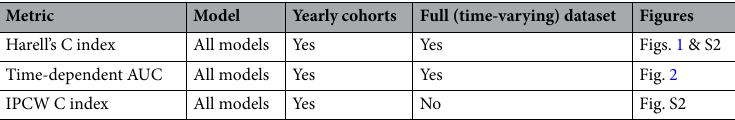
Table 2. Evaluation